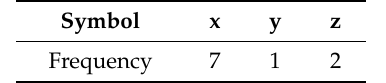
Table 4. Frequencies of letters in ‘xxyxxzxzxx’